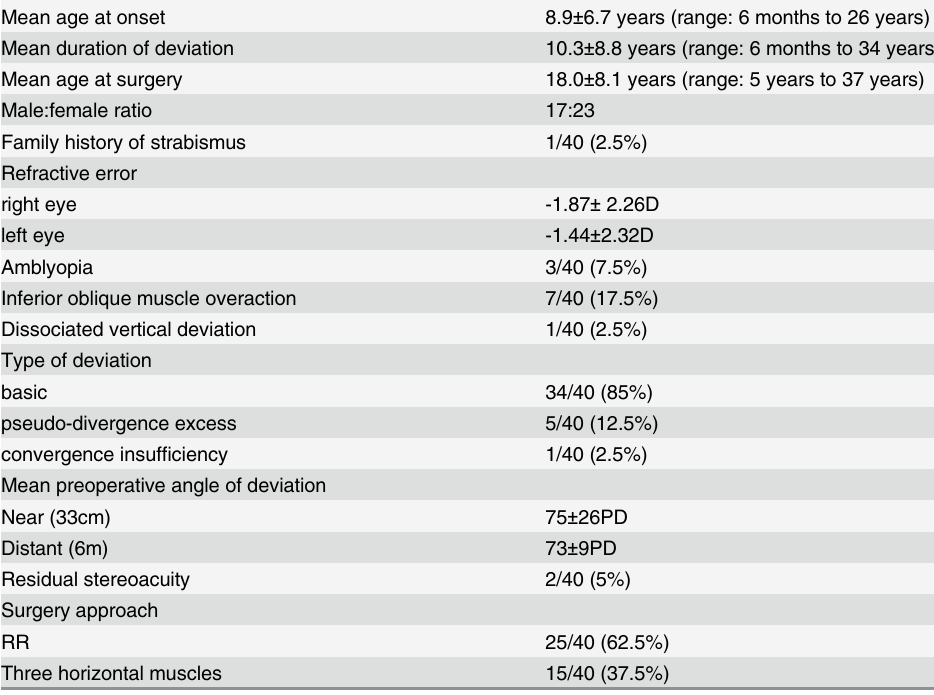
Table 1. Clinical characteristics of patients with large angle